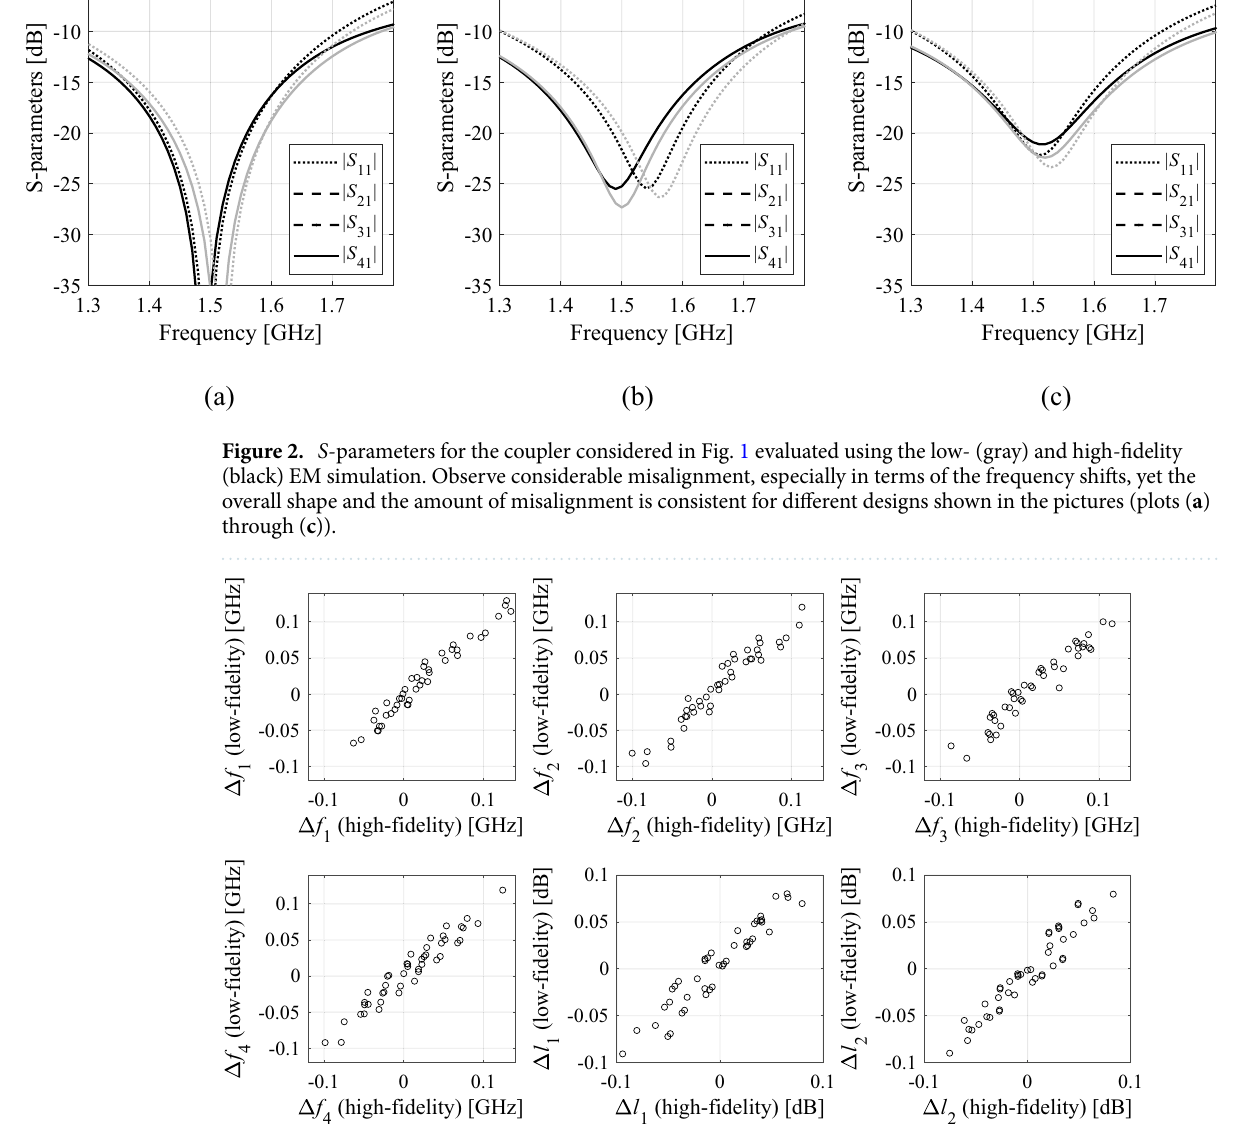
Figure 3. Scatter plots of feature coordinate differentials Δ p j = p j ( x k ) − p j ( x l ) computed for all pairs of ten designs { x k } k = 1,…,10 , generated in the vicinity of a nominal vector x (0) for a microwave coupler considered in Fig. 1. Horizontal and vertical axis correspond to the differentials of the high- and low-fidelity model,